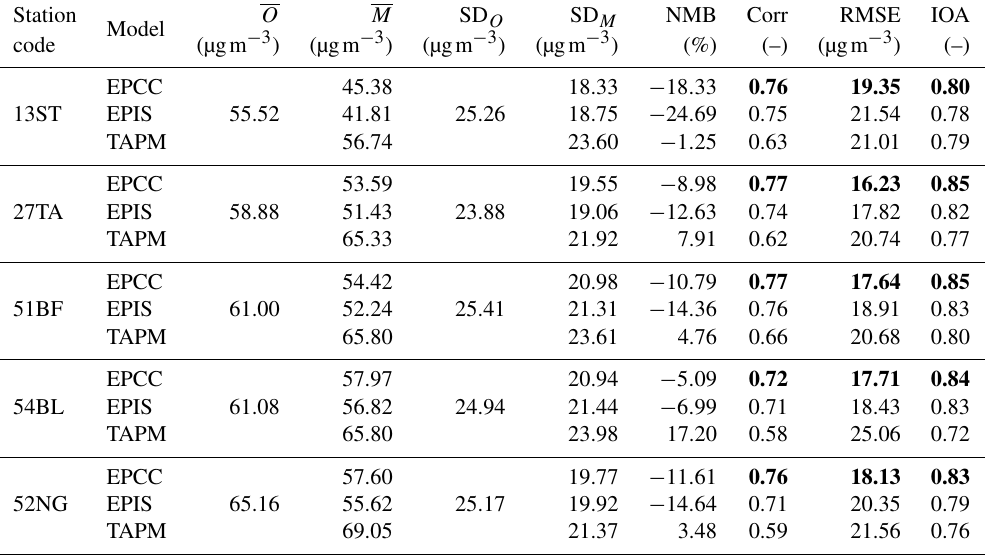
Table 8. Model performance statistics of EPISODE–CityChem (EPCC), standard EPISODE (EPIS) and TAPM for the temporal variation of O 3 based on the daily maximum of the 8h running mean concentration at all stations with sufficient data available in 2012. Bold numbers represent model results with better performance for Corr, RMSE and IOA per